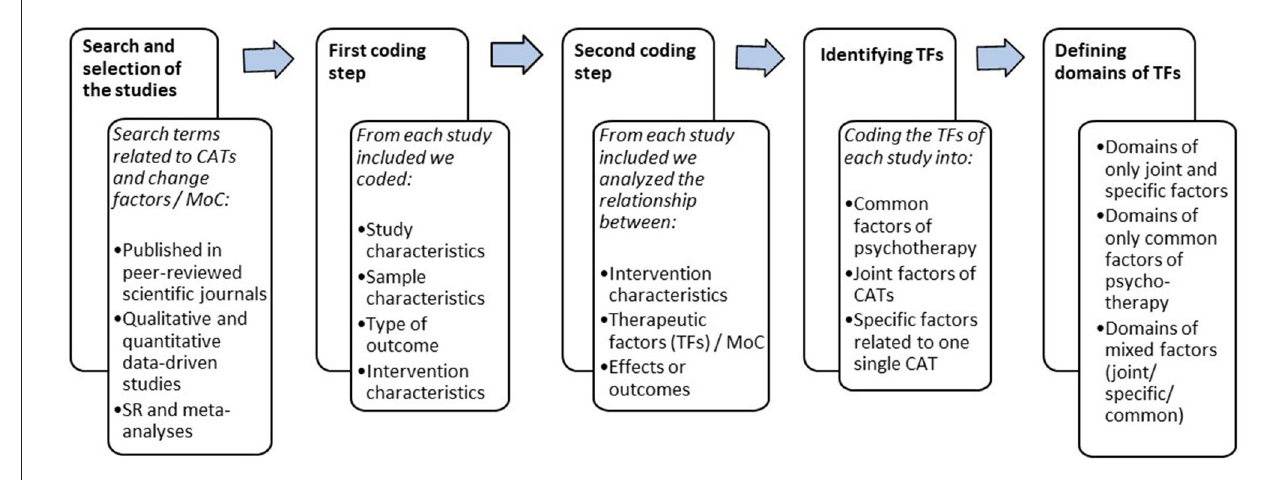
FIGURE 3 | Overview of the steps of data collection and